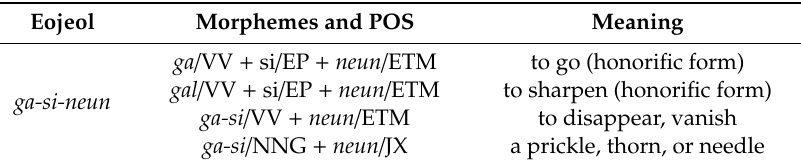
Table 1. An example of a morphology analysis.